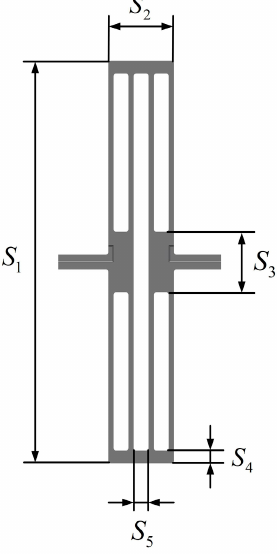
Figure 5. The main structural parameters of the stress-released structure of the BFVG.